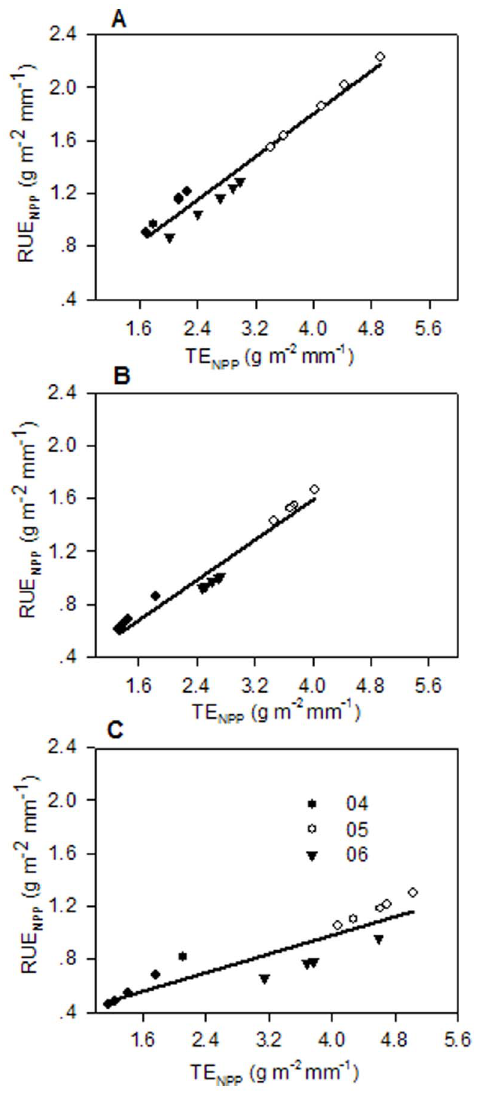
Figure 4. Relationship between RUE NPP (g m 2 2 mm 2 1 ) and TE NPP (g m 2 2 mm 2 1 ). Site UG79 (A), site WG (B), and site HG (C). The data for each site were from 2004, 2005 and 2006. The regression equations for UG79: y=0.177 + 0.406 x, r 2 =0.9542, n=15, P , 0.001; WG: y=0.084 + 0.370 x, r 2 =0.9626, n=15, P , 0.001; HG: y=0.2734 + 0.176 x, r 2 =0.8055, n=15, P , 0.001. RUE NPP =rain-use efficiency based on total net primary productivity; TE NPP =transpiration efficiency based on total net primary productivity. Same symbols as in Figure 2.